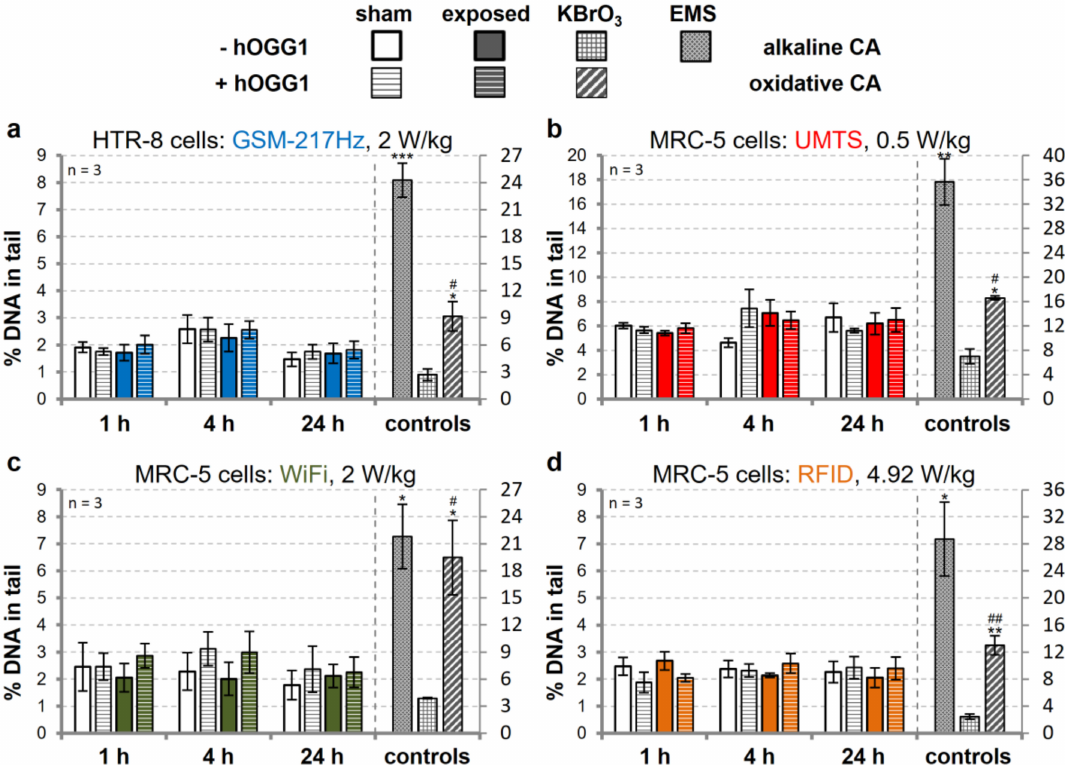
Figure 3. Assessment of oxidative DNA damage in wEMF-exposed human cells. Immortalized HTR-8 / SVneo (HTR-8) trophoblasts ( a ) and primary MRC-5 lung fibroblasts ( b – d ) were exposed to the indicated doses of intermittent (5 / 10 min on / o ff ) wEMF signals (colored bars by signal type) or sham-exposed (white bars) for the duration indicated. Concomitant to wEMF exposure, cells were treated with 0.5 µ L / mL EMS (positive control for DNA strand break induction) and 0.5 mM KBrO 3 (positive control for induction of oxidative DNA damage) for 1 and 4 h, respectively. Exposed / treated cells were divided and subjected to enzyme bu ff er- or hOGG1-incubation before electrophoresis. Data represent arithmetic means ± SEM of three independent experiments. Asterisks and hashes represent the statistical significance levels of Student’s t -test: * ,# p < 0.05; ** ,## p < 0.01; *** p < 0.001, comparing wEMF-exposed as well as control cells with sham-exposed samples and data of hOGG1-treated (oxidative DNA lesions) slides with those of bu ff er-treated slides (DNA strand breaks only),